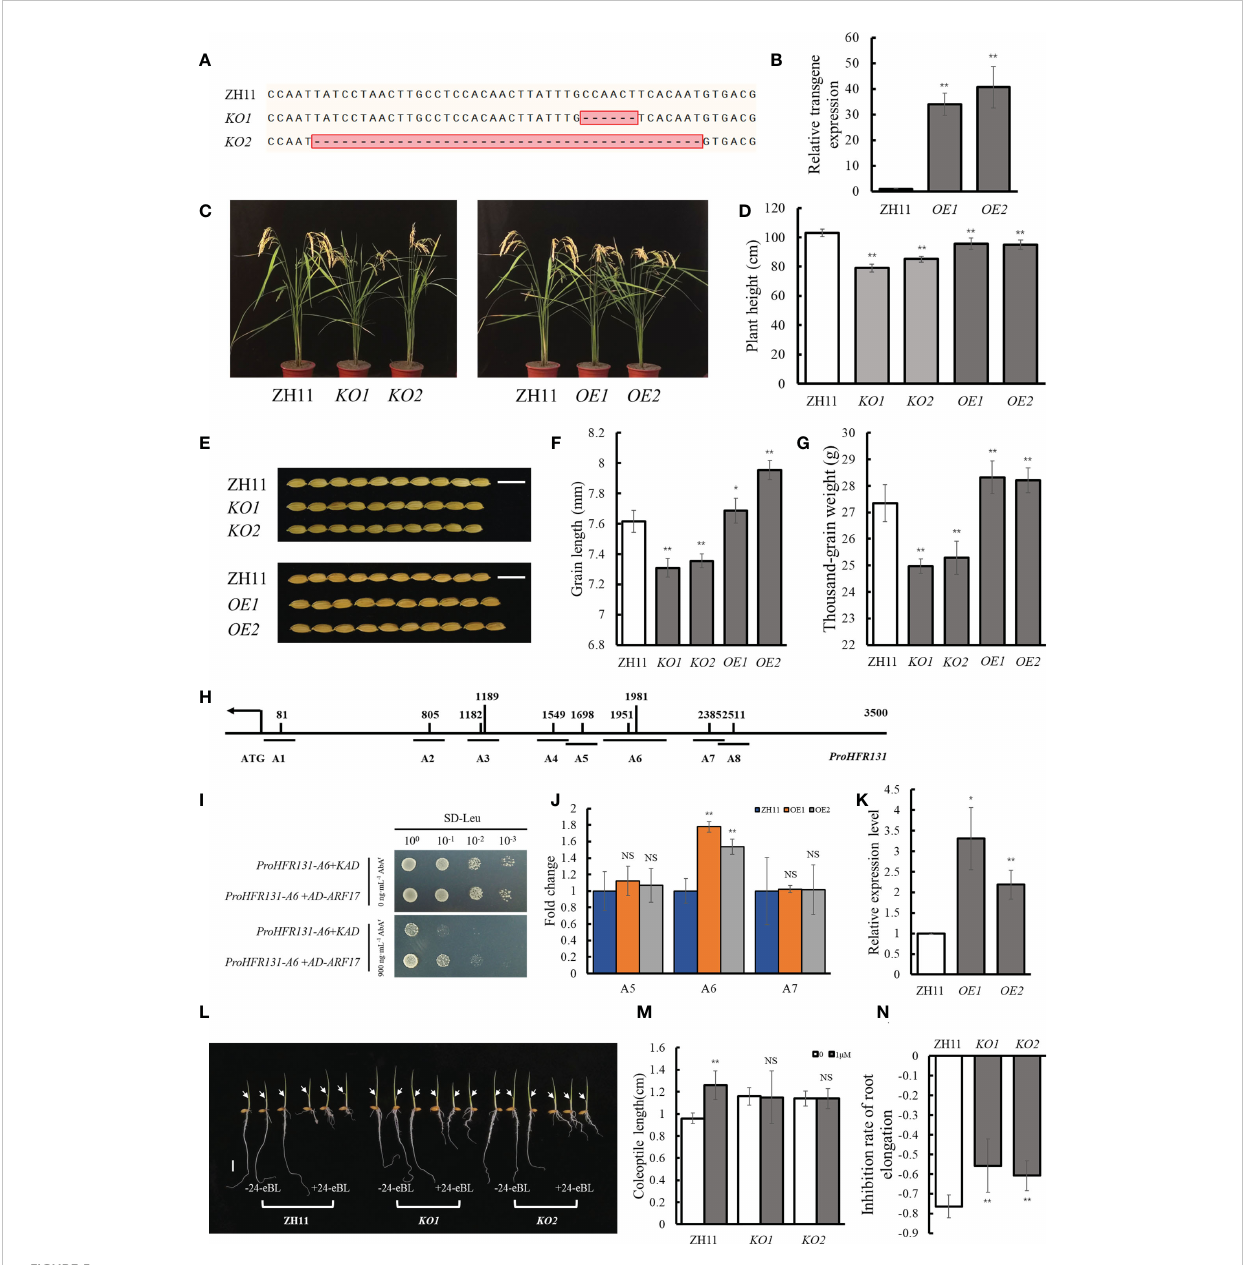
FIGURE 5 Relationship between OsARF17 and HFR131 . (A) Target site in the OsARF17 sequence of rice ‘ ZH11 ’ in the OsARF17 knockout lines. (B) Transgene expression level of OsARF17 . OsActin was used as an internal reference. (C, D) Plant architecture and plant height of OsARF17 knockout lines and overexpression lines. (E) Grain morphology of OsARF17 knockout lines and overexpression lines. Bar = 1 cm. (F, G) Grain length and thousand-grain weight of OsARF17 knockout lines and overexpression lines. (H) Positions of 10 auxin response elements in the HFR131 promoter. (I) Yeast one- hybrid assays to detect interaction between OsARF17 and the promoter of HFR131 . (J) ChIP-qPCR analysis to detect interaction between OsARF17 and the promoter of HFR131 . Fold change is relative to ZH11. OsActin was used as an internal reference. A5, A6, and A7 corresponding to the fragments indicated in Figure 5A. (K) Relative expression level of HFR131 in OsARF17 overexpression lines. OsUBQ5 was used as an internal reference. (L) Effect of 24-eBL on coleoptile and root elongation in seedlings. The arrows indicate the top of the coleoptile. Bar = 1 cm. (M) Coleoptile length of ZH11 and OsARF17 knockout-line seedlings in the presence or absence of 1 m M/L 24- epibrassinolide (24-eBL). (N) Inhibition of root elongation in ZH11 and OsARF17 knockout lines under 1 m M/L 24-eBL treatment. * P < 0.05, ** P < 0.01, NS non-signi fi